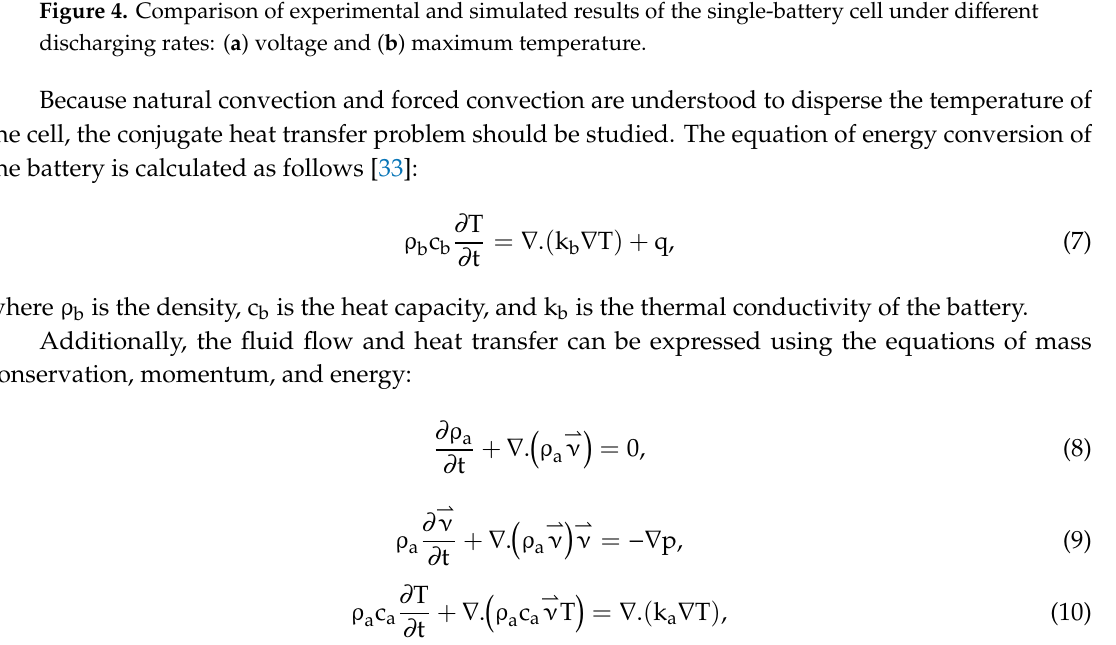
Figure 4. Comparison of experimental and simulated results of the single-battery cell under different